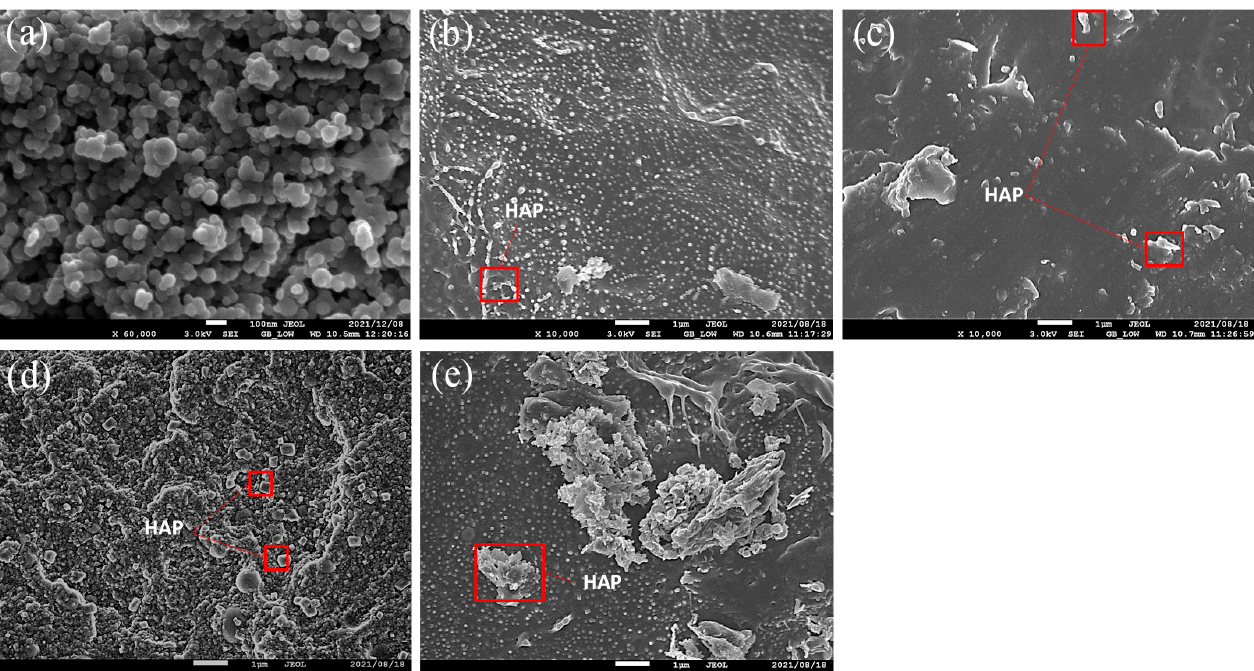
Figure 1. SEM micrographs of ( a ) HAP, ( b ) PCL 1, ( c ) PCL 3, ( d ) PCL 5, and ( e ) PCL 7.